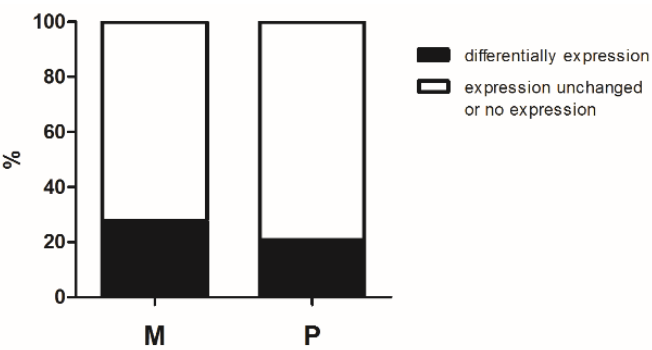
Figure 4. Ratio of differentially expressed imprinted genes between the maternal and paternal expressed imprinted genes. The results are presented as the percentage of differentially imprinted genes in maternal and paternal expressed imprinted genes respectively. Y axis indicates the expression ratio (represented as %). The maternal differentially expression ratio was 27.77% (5/18) and the paternal differentially expression ratio was 20.83% (5/24). p = 0.720 using Fisher’s Exact Test. P, paternal expressed genes; M, maternal expressed genes.